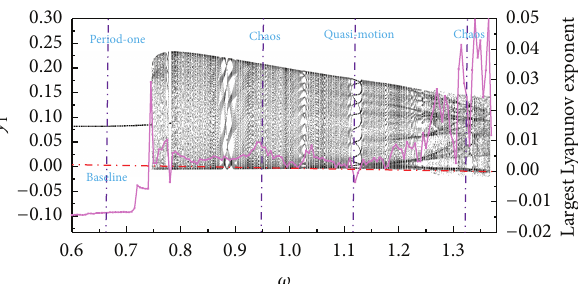
Figure 4: Bifurcation diagram of the steady-state response 𝑦 1 and its largest Lyapunov